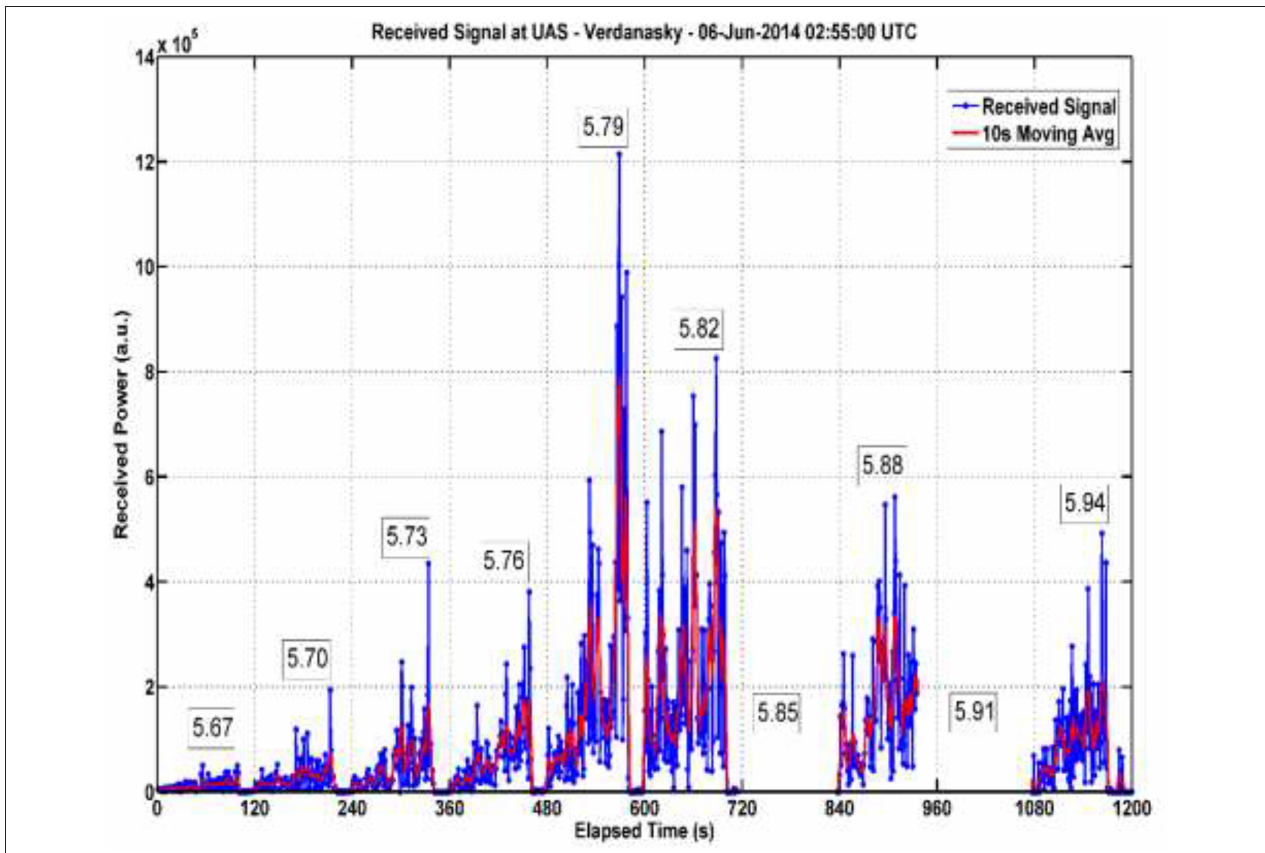
FIGURE 5 | Time series of the received power at UAS on 06/06/2014. Here the heating frequencies are given in MHz. The intensity of the received HF signals vs. elapsed time (i.e., the varying heating frequency) are shown by the color traces [adapted from (Najmi et al.,